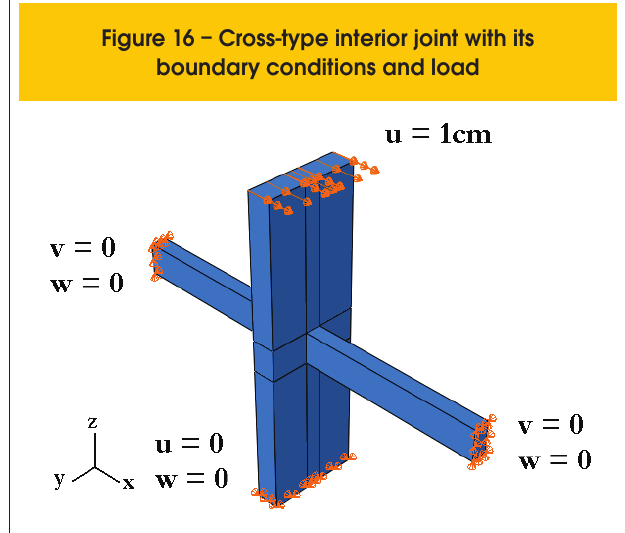
Figure 16 – Cross-type interior joint with its boundary conditions and load